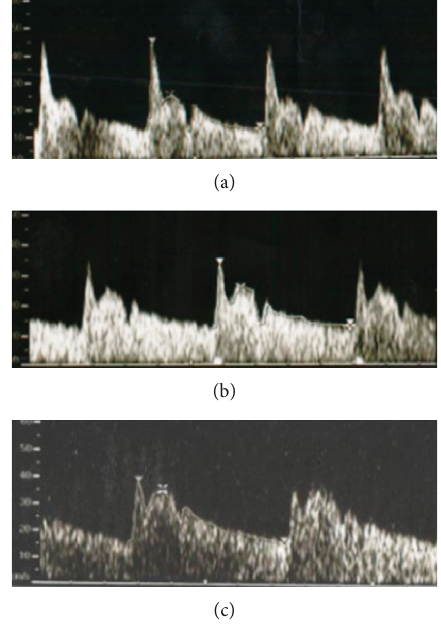
Figure 3: Representation of Doppler velocimetry of ophthalmic artery in a normotensive volunteer (PR � 0.56; P2 � 24.25) (a) and in volunteers with late-onset preeclampsia (LOPE: PR � 0.78; P2 � 25.24) (b) and early-onset preeclampsia (EOPE: PR � 0.93; P2 � 35.23) (c). PR is the P2/PSV ratio, and P2 is the second peak systolic